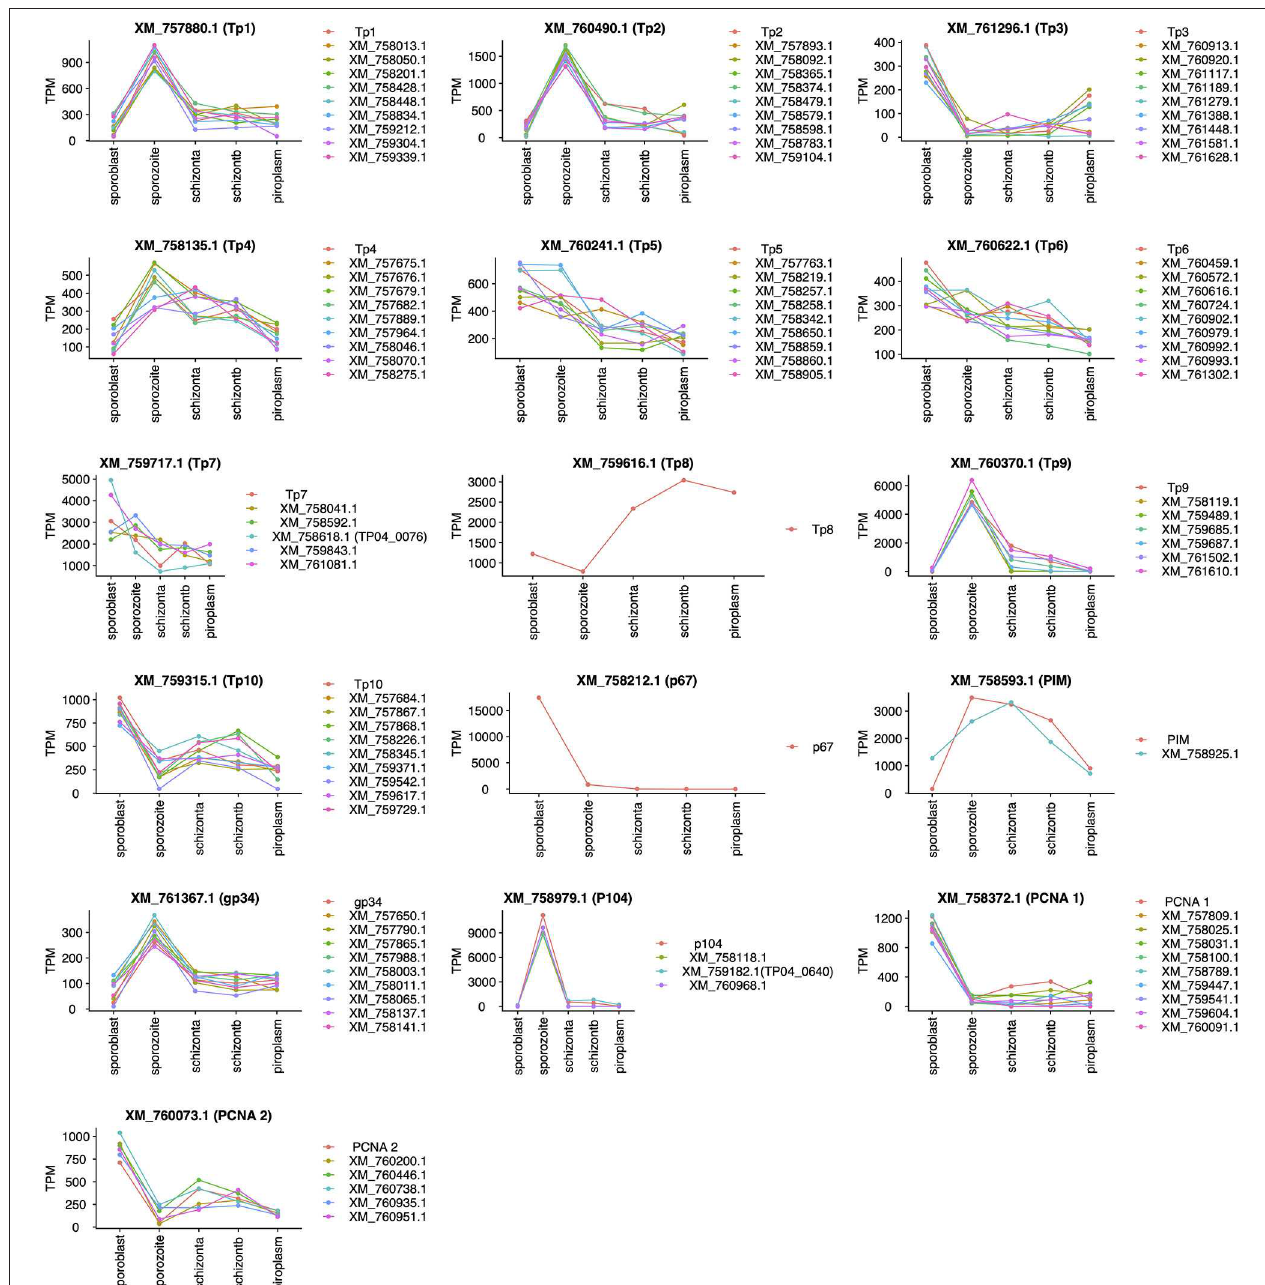
FIGURE 5 | Genes with expression profiles similar to known Theileria parva antigens’ genes. Sporoblast, sporozoite, and schizont_a are transcriptome data collected from our previous work (16), whereas schizont_b and piroplasm are transcriptome data generated from this study. Each line in a unique color represents a specific gene with its GenBank accession number. Each plot represents the profiling of genes (GenBank accession number listed) having a similar expression profile to the known antigen (top of the